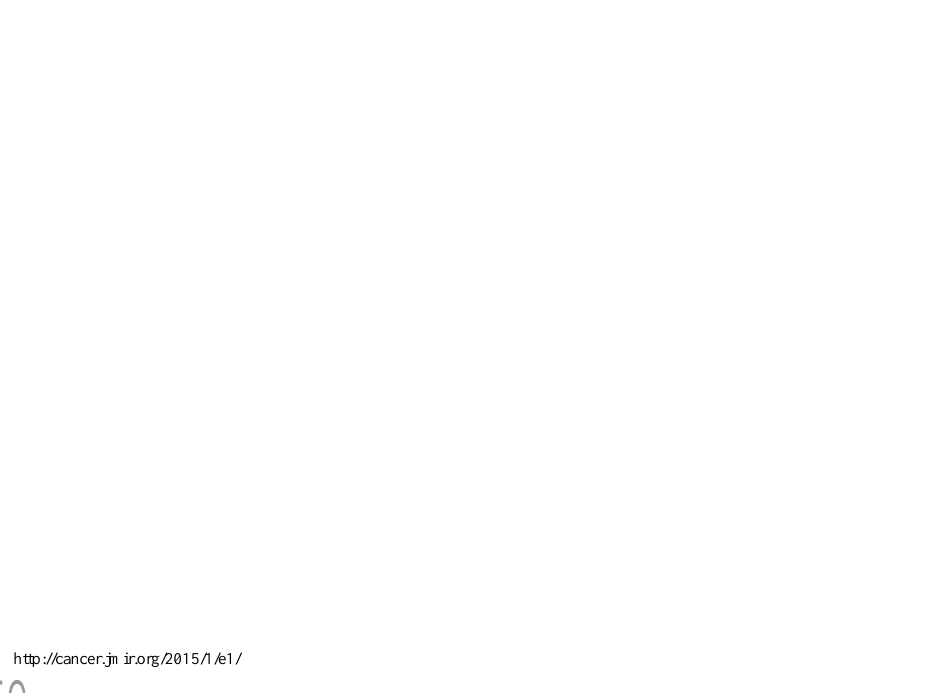
P valueProfessional